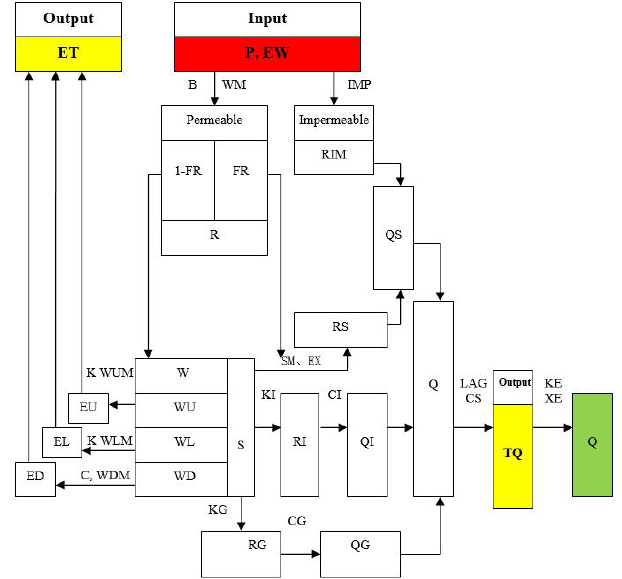
Figure 1. Flow chart of the XAJ model. The red box denotes the model input consisting of precipitation ( P ) and pan evapora- tion (EW); the yellow boxes denote the model-simulated fluxes in- cluding evapotranspiration (ET) and discharge (TQ); the green box denotes the discharge after routing simulation (usually using the Muskingum method). Symbols outside the boxes are model param-